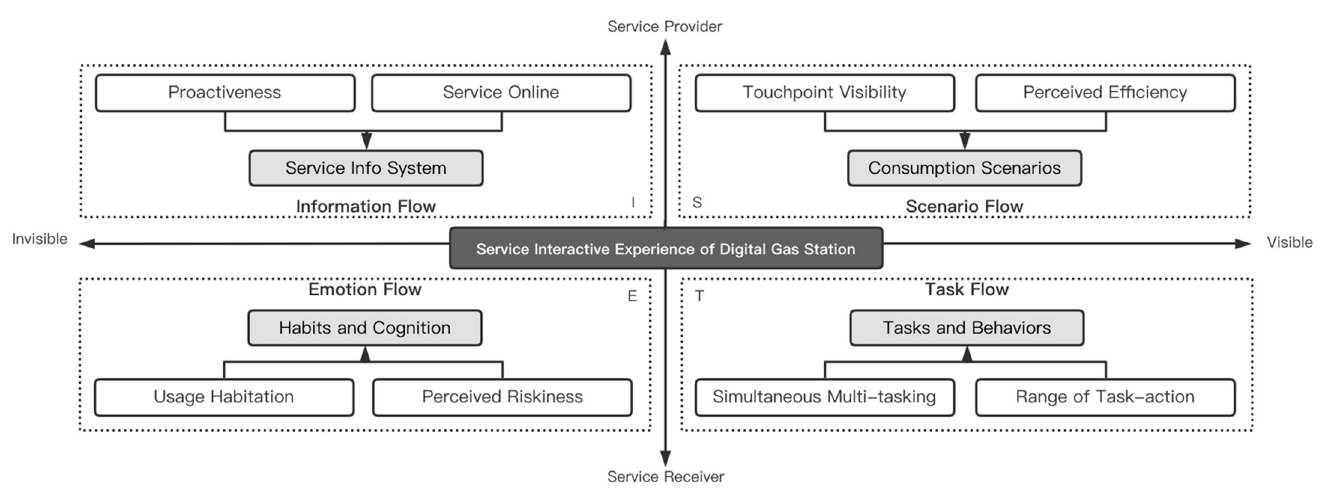
Figure 2. The SITE model of influencing factors of service interactive experience of digital gas stations.